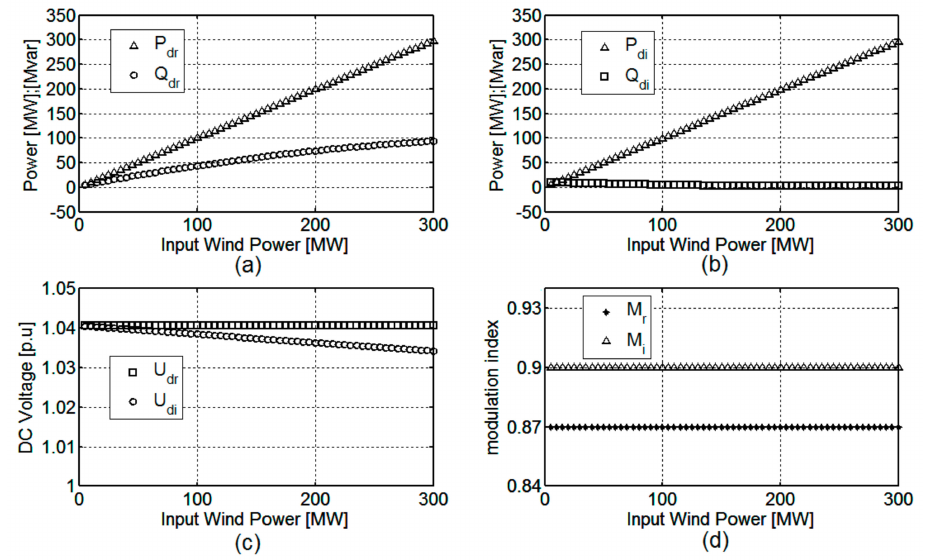
Figure 9. Steady-state curves without optimization (DFIG pf = 1.0): ( a ) Active and reactive power at the rectifier side of the VSC-HVdc model; ( b ) active and reactive at the inverter side of the VSC-HVdc model; ( c ) DC voltage in the VSC-HVdc model; ( d ) modulation indexes in the VSC-HVdc